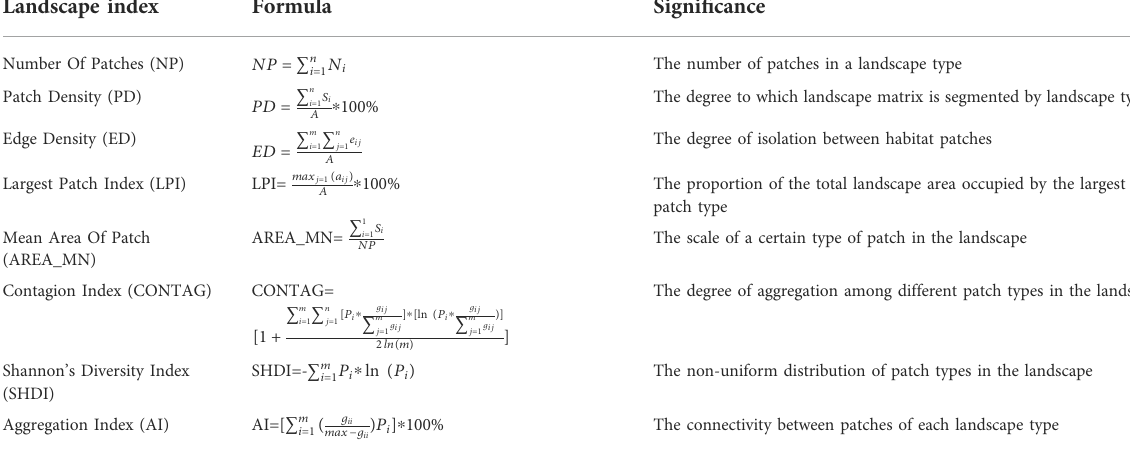
TABLE 6 Ecological landscape index and signi fi cance. Landscape